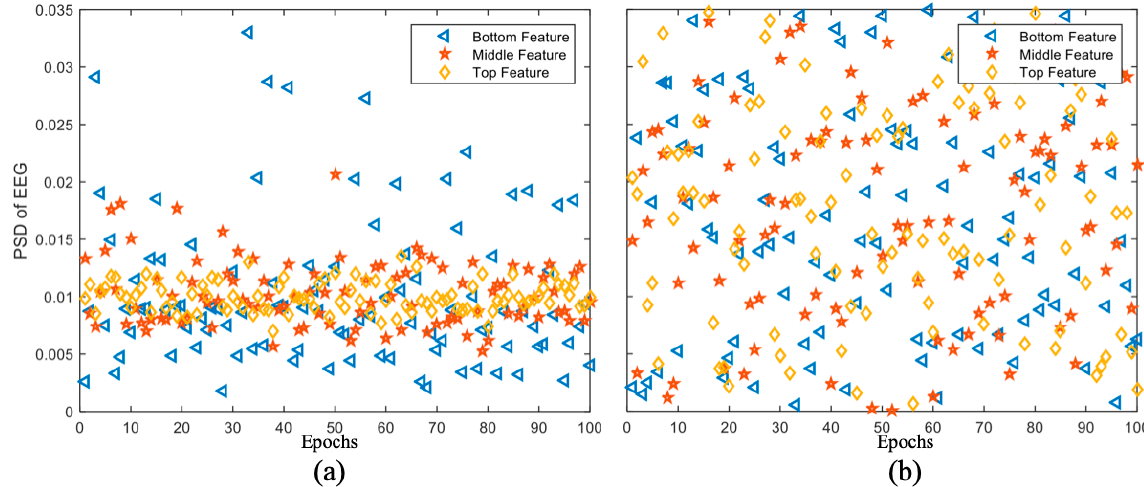
Figure 10. Feature distribution map with ( a ) the removal of data from channels P3, P4, PZ, CPZ, CP3, and CP4; ( b ) removal of data removed from F3, F4, FZ, FP1, FP2, and FCZ. and CP4; ( b ) removal of data removed from F3, F4, FZ, FP1, FP2, and FCZ.